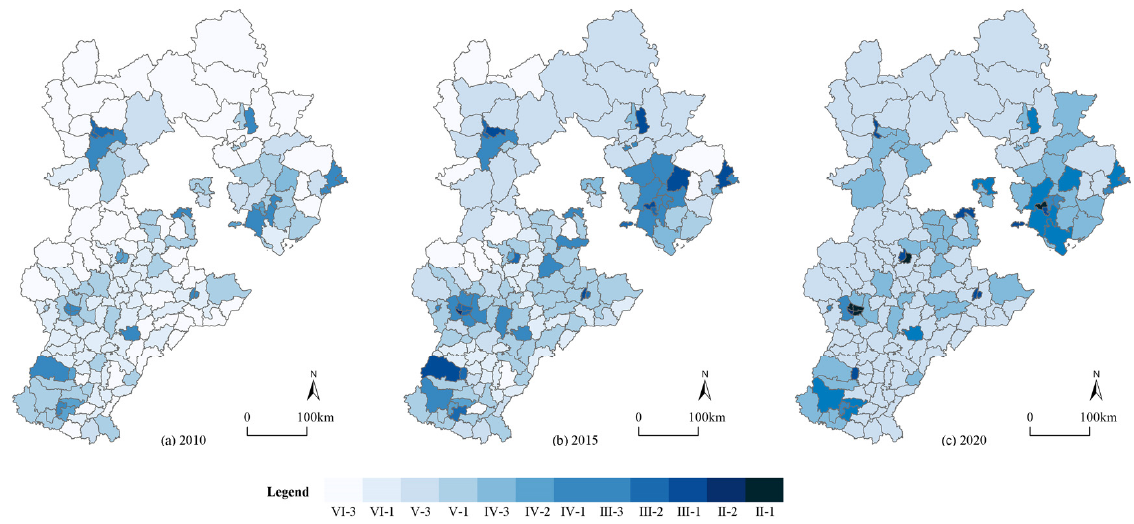
Figure 7. Spatial distribution of the coupling coordination type of 167 counties in Hebei. ( a ) Cou- pling coordination type in 2010; ( b ) coupling coordination type in 2015; ( c ) coupling coordination type in 2020.